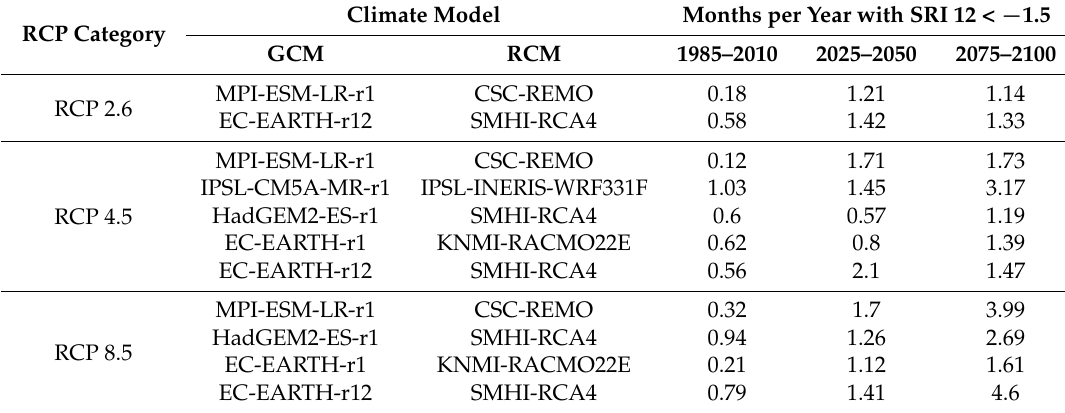
Table 4. Mean number of months with drought per year (SPI12 < − 1.5).